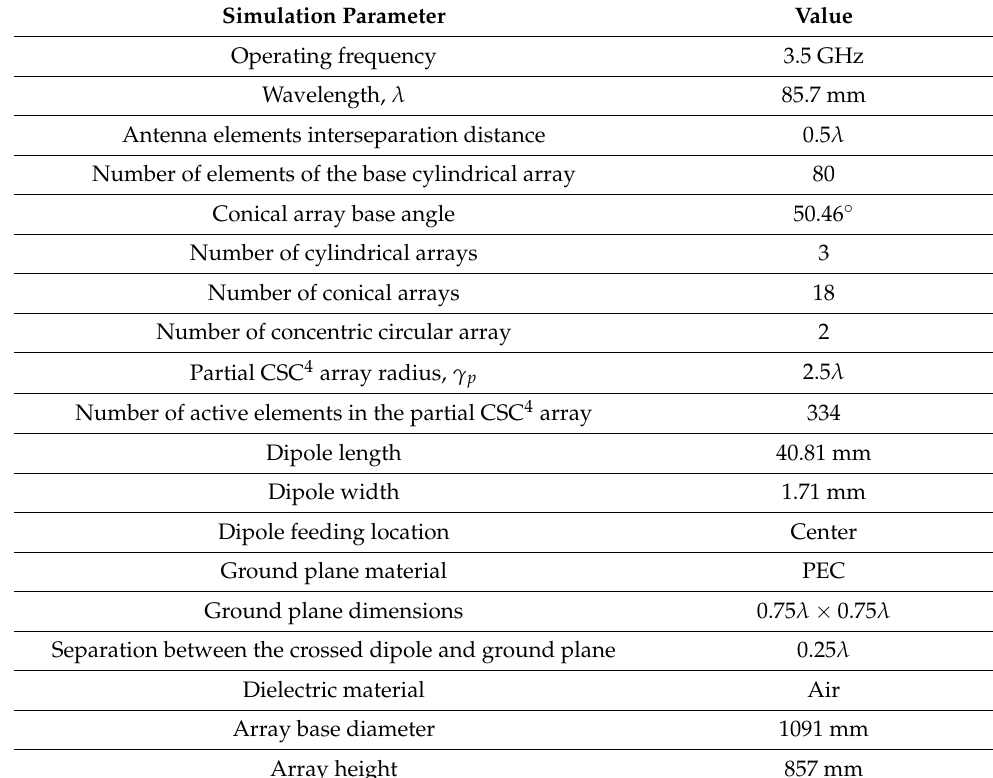
Table 5. Simulation parameters for frontal-oriented mainlobe partial CSC 4 using crossed dipole as an antenna